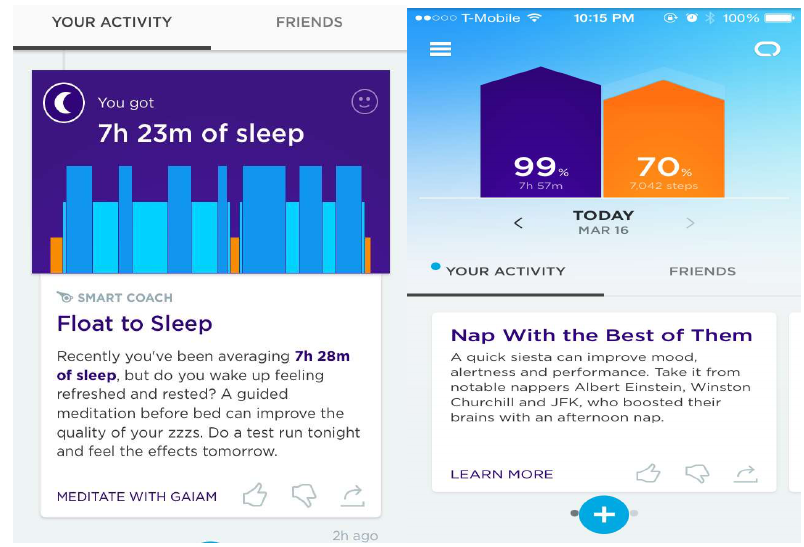
Figure 2. Tips and information provided by the app screenshot.